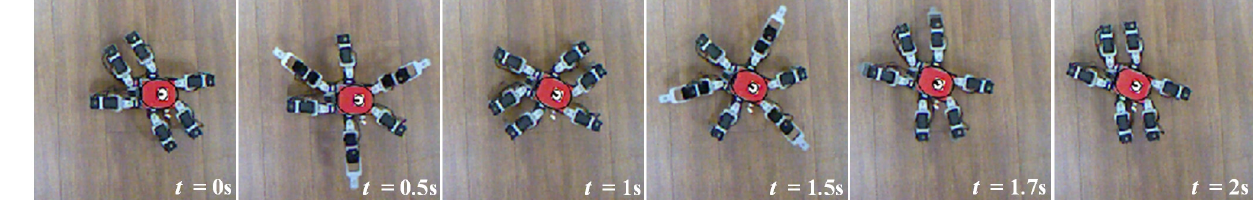
Figure 16. The experimental screenshots of the tripod gait.